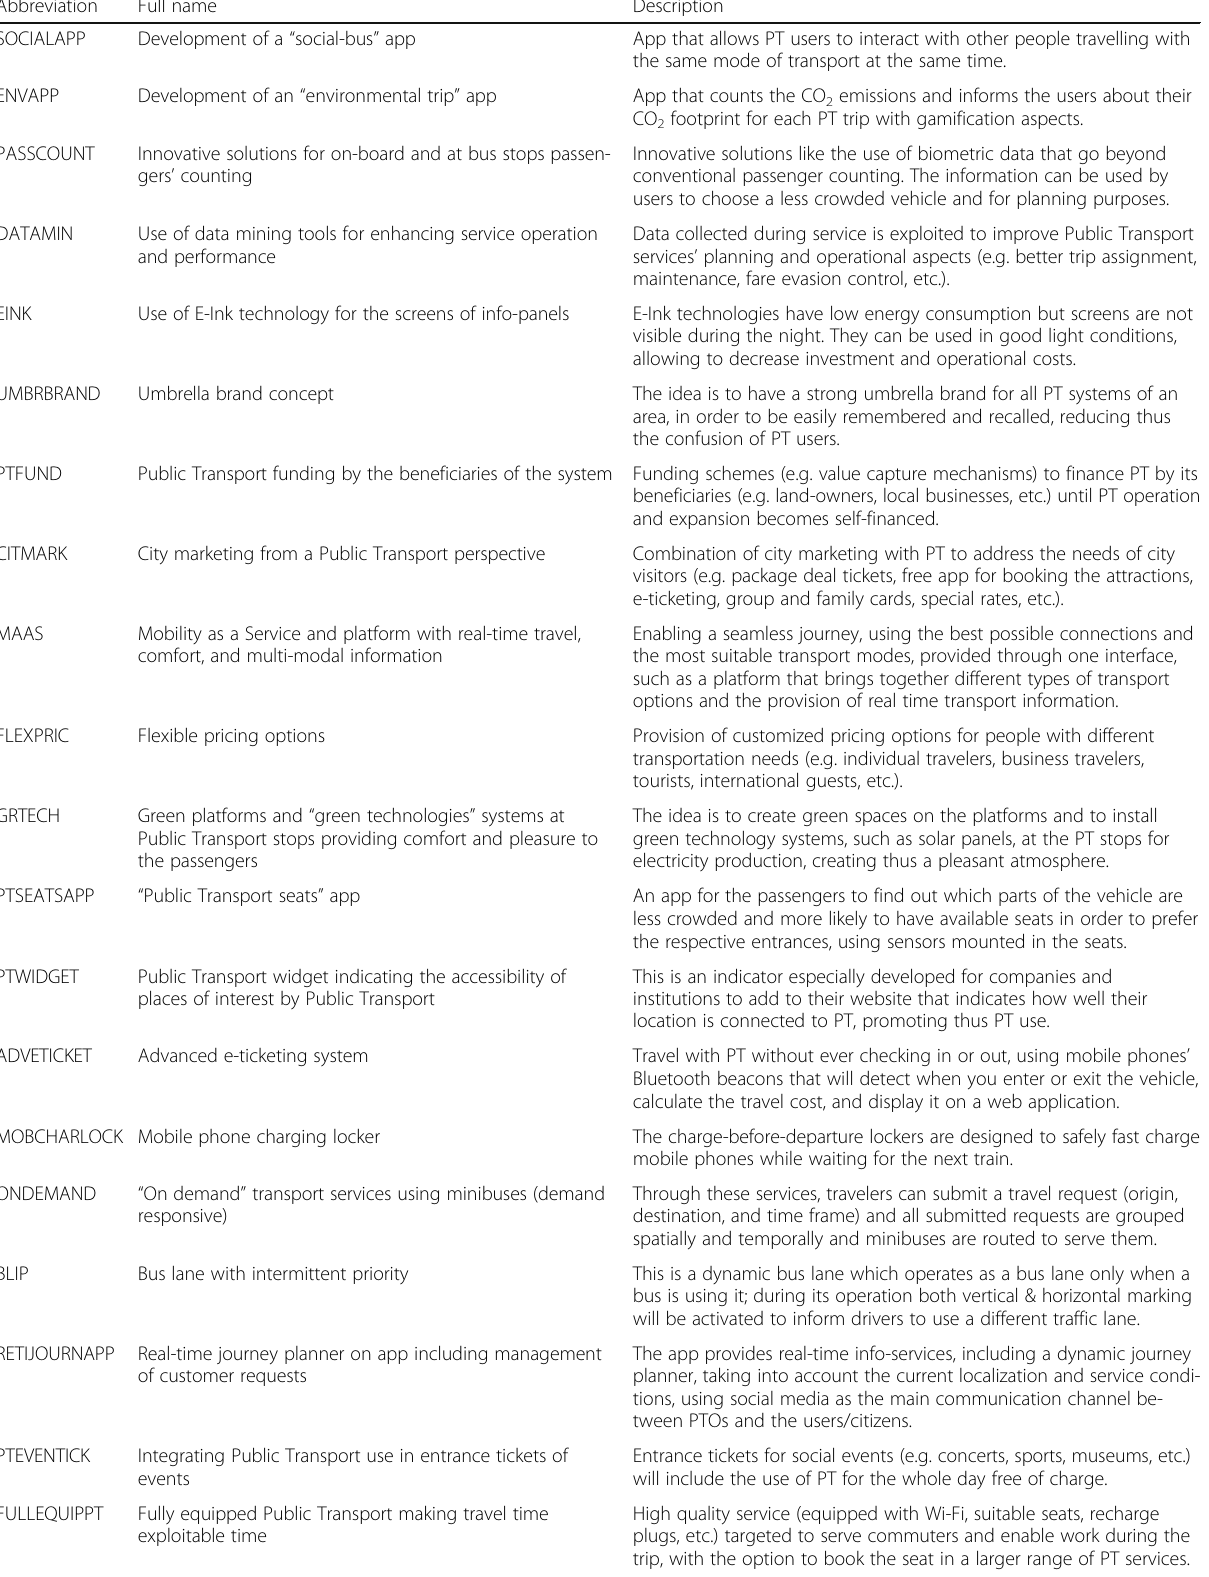
Table 2 The innovations that were included in the evaluation questionnaire (abbreviations, full names, and